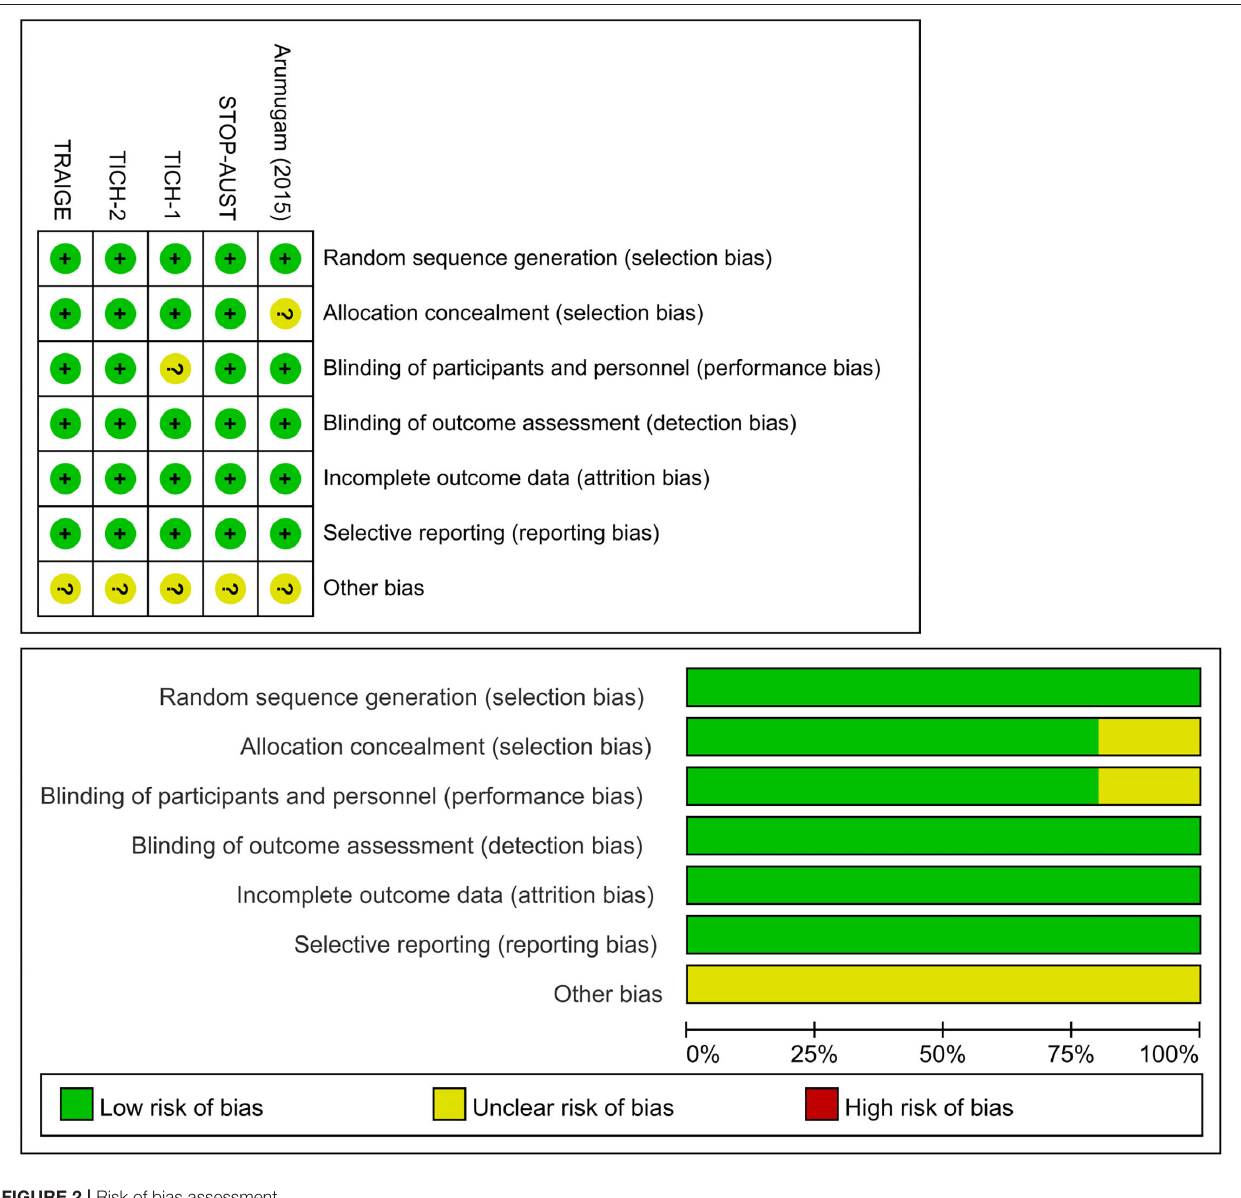
FIGURE 2 | Risk of bias assessment.